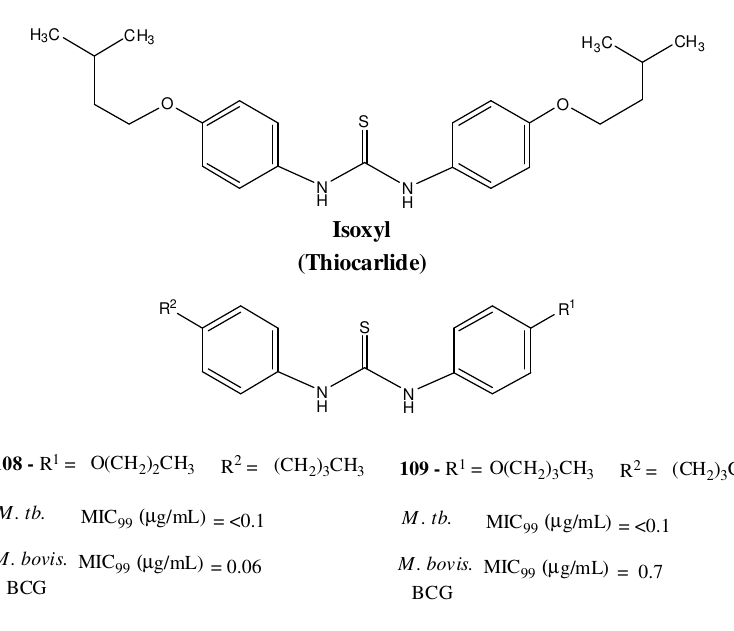
FIGURE 9. Structures of thiocarlide (isoxyl) and compounds 108 and 109 .